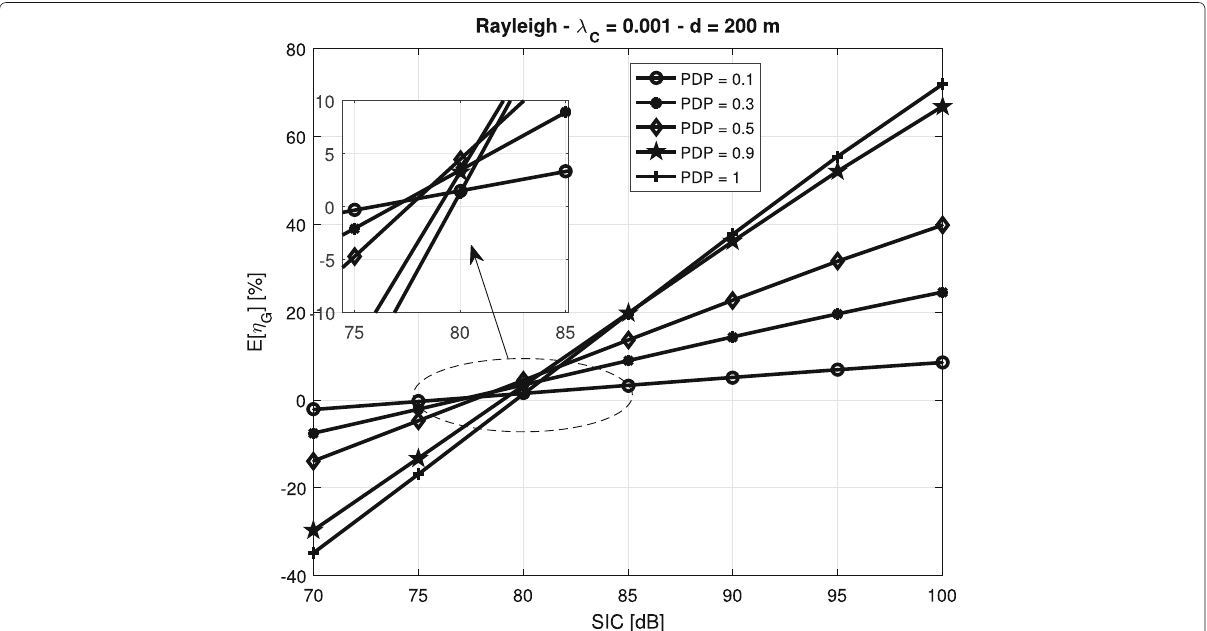
Fig. 3 PD spectral efficiency gain in frequency selective fading channel. Spectral efficiency gain E [ η G ][%] vs. SIC at different values of PDP, for frequency selective Rayleigh channel model with λ C = 0.001, link distance d = 200 m and the SPD strategy